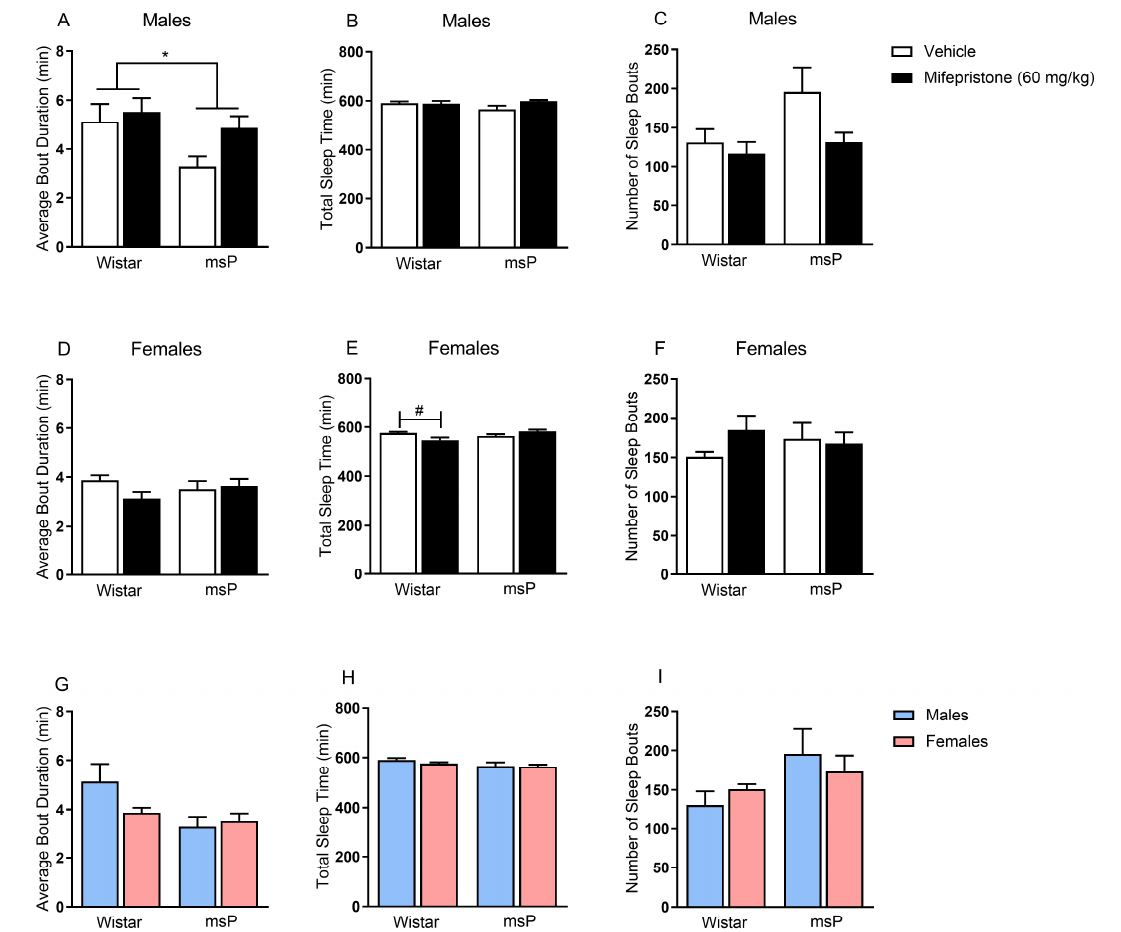
Figure 2. Effect of glucocorticoid receptor (GR) antagonist mifepristone on sleep disturbances in both male and female Wistar and msP rats. Mifepristone (60 mg/kg) was injected intraperitoneally, and rats were subjected to the comprehensive lab animal monitoring system (CLAMS) test after 90 min. Mifepristone had no effect on ameliorating sleep disturbances. ( A ) average bout duration, ( B ) total sleep time, ( C ) number of sleep bouts in vehicle ( n = 8) or mifepristone-treated ( n = 8) male Wistar rats and vehicle ( n = 7) or mifepristone-treated ( n = 8) male msP rats. ( D ) average bout duration, ( E ) total sleep time, ( F ) number of sleep bouts in vehicle ( n = 8) or mifepristone-treated ( n = 8) female Wistar rats and vehicle ( n = 8) or mifepristone-treated ( n = 8) female msP rats. ( G ) average bout duration, ( H ) total sleep time, ( I ) number of sleep bouts in male Wistar ( n = 8) and male msP ( n = 7) rats, female Wistar ( n = 8) and female msP ( n = 8) rats. Results are expressed as mean ± SEM. Two-way ANOVA followed by Fisher’s LSD protected post hoc tests when the interaction between variables occurred. Main effect of genotype, * p ≤ 0.05. Post hoc test revealed significant differences between treatments, # p ≤